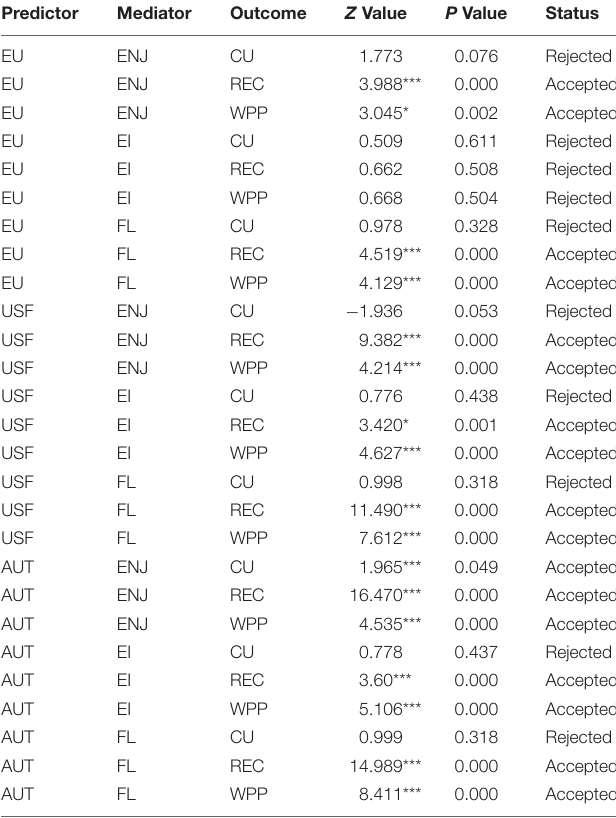
TABLE 6 | Mediation effect. Predictor